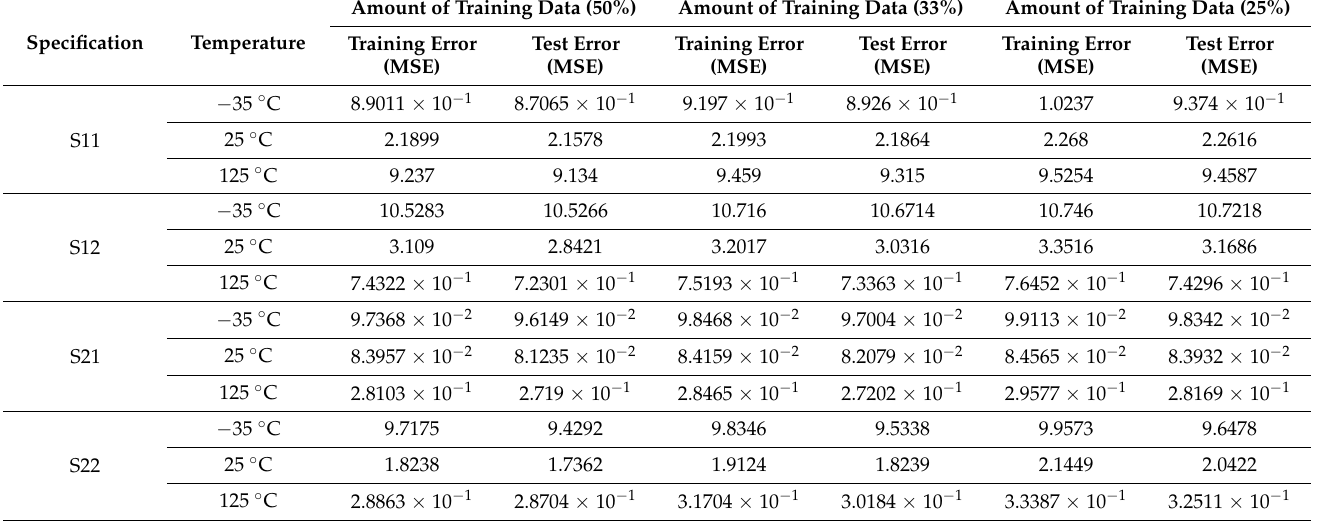
Table 1. Effect of different amounts of training data on the